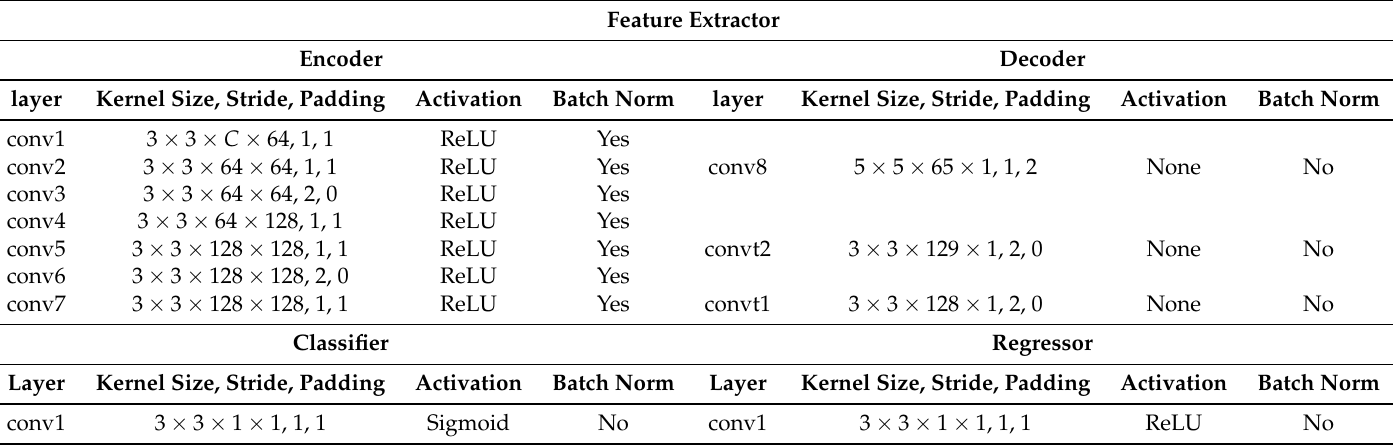
Table 2. Details of network architectures. Each layer of the encoder feeds sequentially into the next layer, from top to bottom (i.e., “conv1” top, so the output of the ”conv7” layer feeds into the “convt1” layer. Additionally, “convt2” and “conv8” layers take not only as input the output from their previous decoder layers but also concatenates the output of the encoder layer of the same row (skip connection). This means the input of the “convt2” layer is the concatenated outputs of the “conv5” and “convt1” layers. The output of the “conv8” layer is the input for the classifier and regressor.